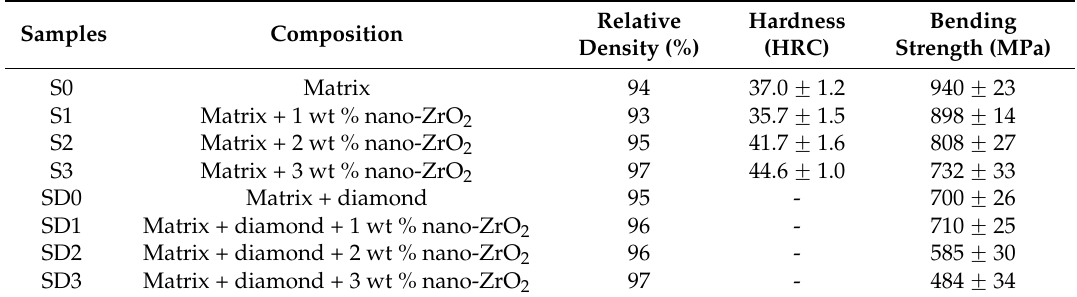
Table 1. The designation, composition and mechanical properties of